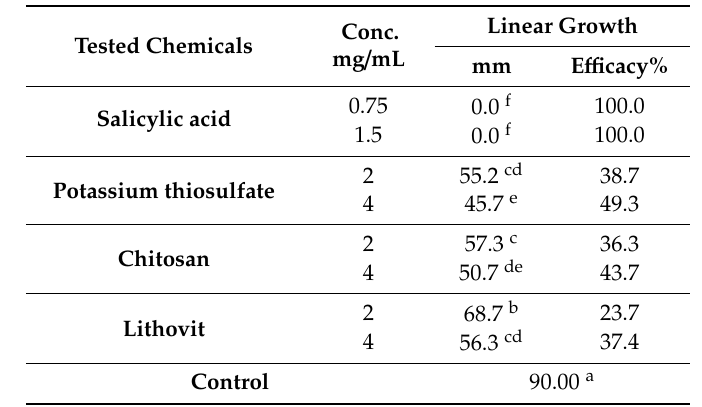
Linear Growth Conc. mg / mL mm E ffi cacy% 0.75 0.0 f